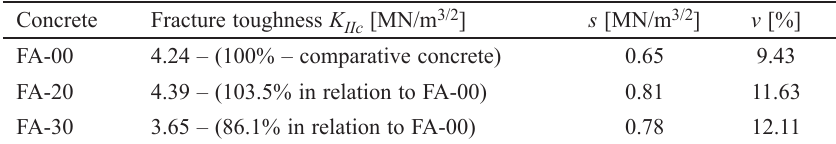
Table 5. Fracture toughness K IIc of concretes